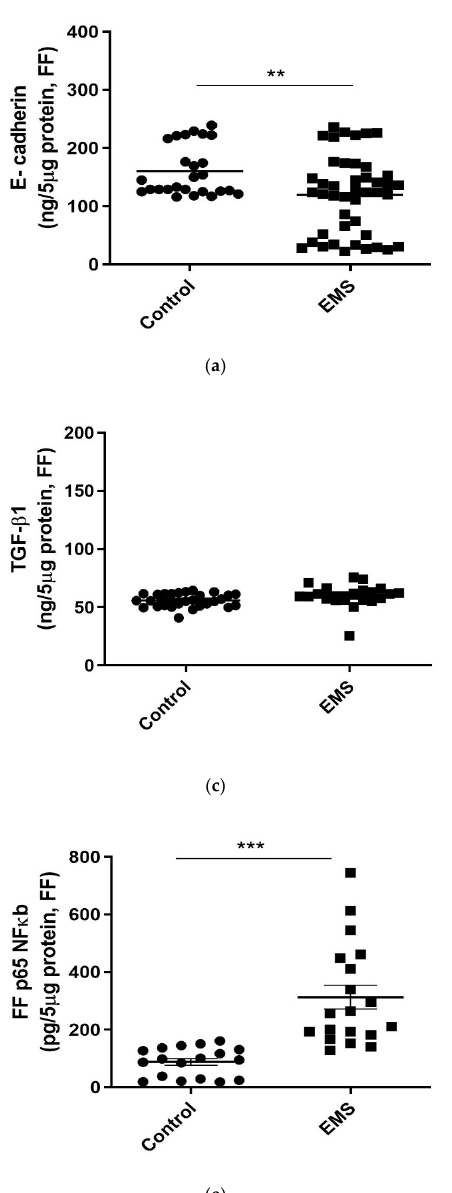
Figure 4. Evaluation of EMT markers (E-cadherin, N-cadherin) and EMT-related inflammatory markers (TGF- β , HIF-1 α , and NF-kB) in FF samples from control and EMS patients. E-cadherin ( a ), N-cadherin ( b ), TGF- β ( c ), HIF-1 α ( d ), and NF-kB (e) levels were assessed by homemade ELISA kits. Data are the mean ± SD of two different experiments, each performed in duplicate. Statistical analysis was performed by unpaired t -test: * p < 0.05, ** p < 0.01, *** p < 0.001 versus control. Finally, FF concentrations of p65 NF-kB were found to be significantly increased in patients with respect to the control group (Figure 4e, p =